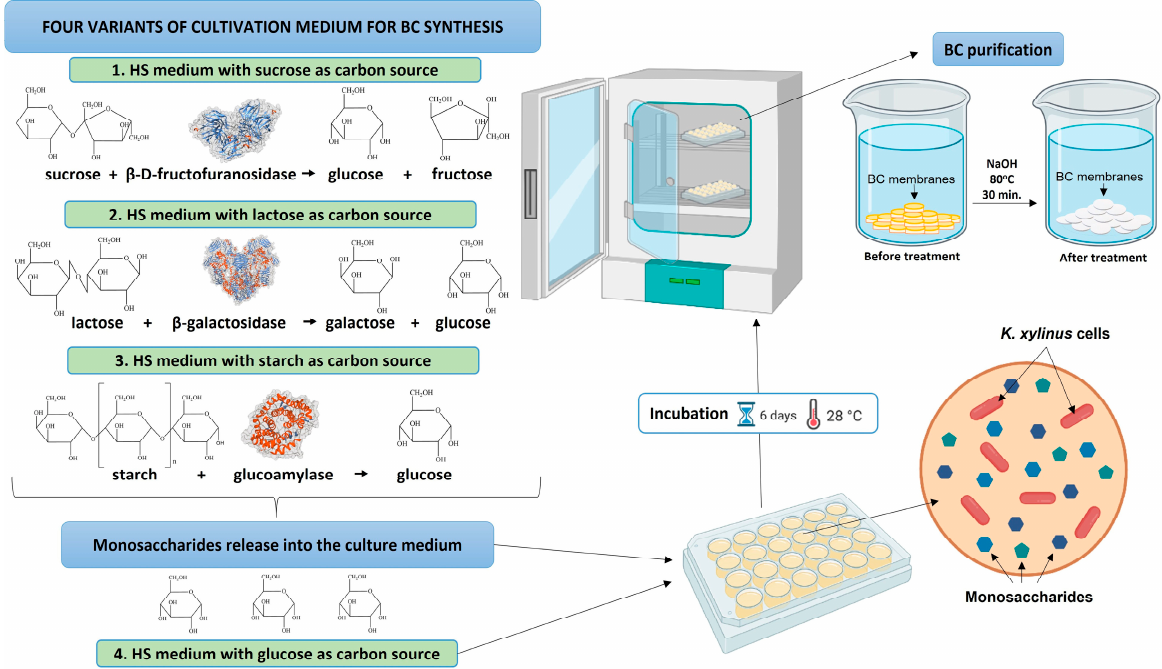
Figure 1. The scheme of the experimental K. xylinus cultivation process in the presence of a combi- nation of oligo- and polysaccharides and specific enzymes.